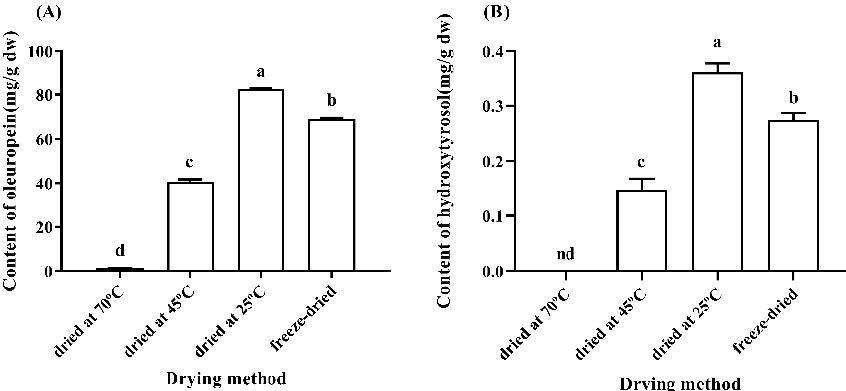
Figure 3. Contents of oleuropein ( A ) and hydroxytyrosol ( B ) in olive leaves after drying in an oven at 70 and 45 °C, room temperature (25 °C) and freeze dryer, respectively. Values are the mean of triplicate experiments and the error bar indicate the standard error of duplicate data. “nd” means “not detected”. Significance data were obtained by analysis of variance (ANOVA). Different lowercase letters (a, b, c and d) on the top of columns represent significant difference ( p < 0.05).